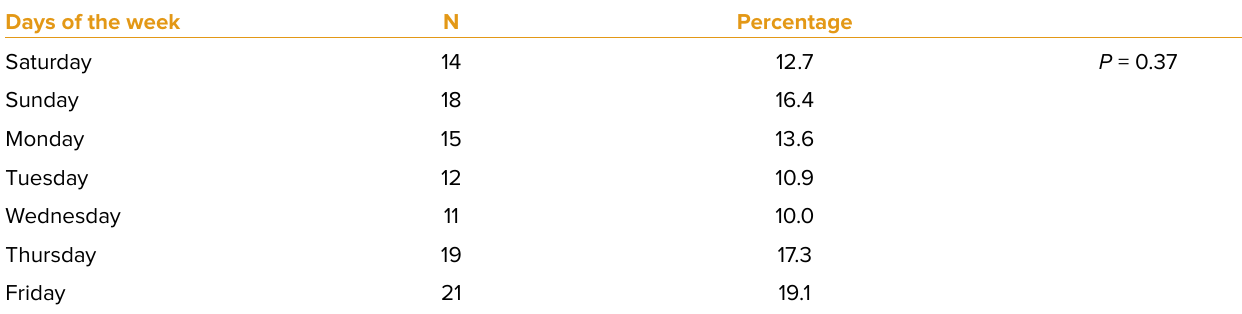
Table 2. Distribution of trauma by days of the